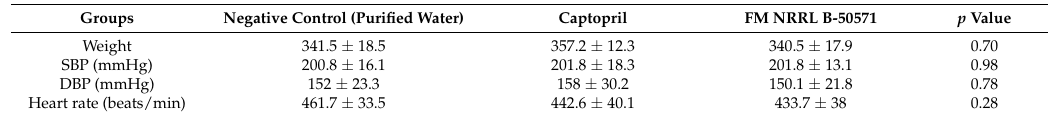
Table 2. Clinical characteristics of SHR.